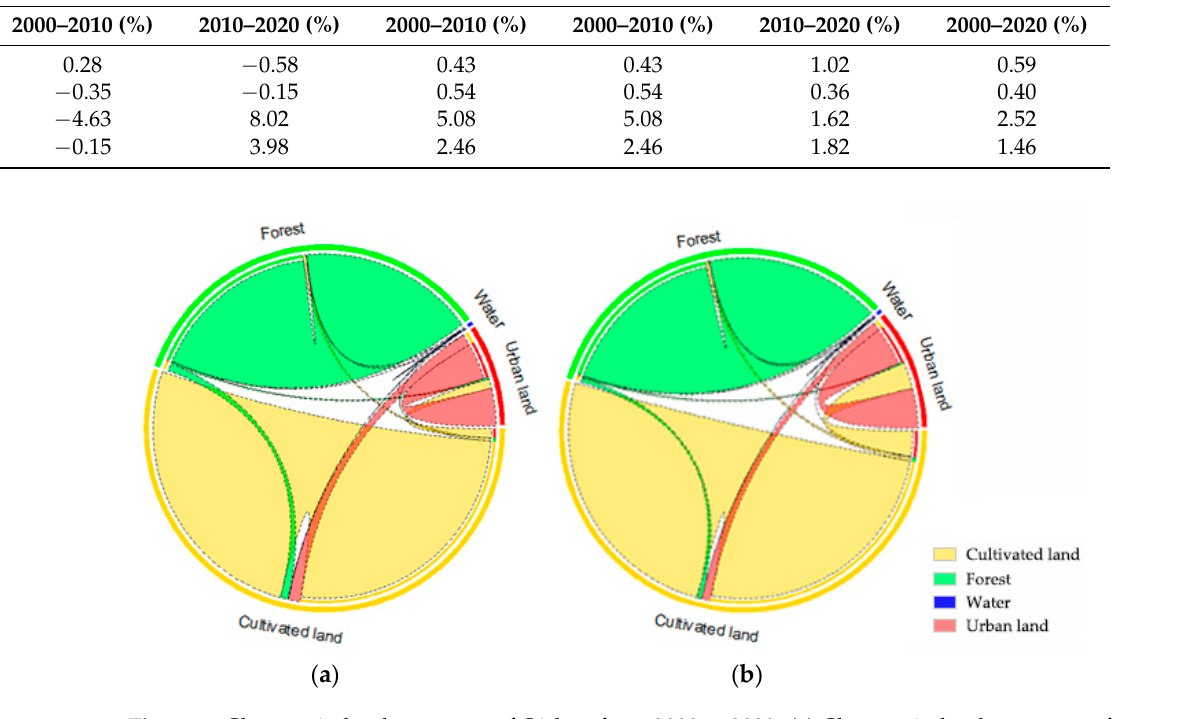
Figure 5. Changes in land use types of Qishan from 2000 to 2020. ( a ) Changes in land use types of Qishan from 2000 to 2010; ( b ) Changes in land use types of Qishan from 2010 to 2020.